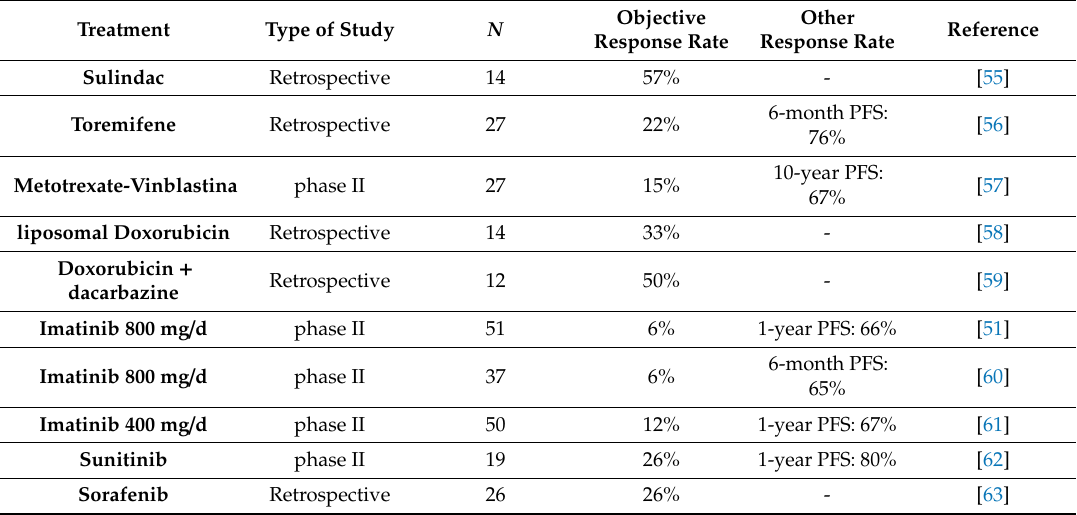
Table 2. Evidence for systemic treatments in adults